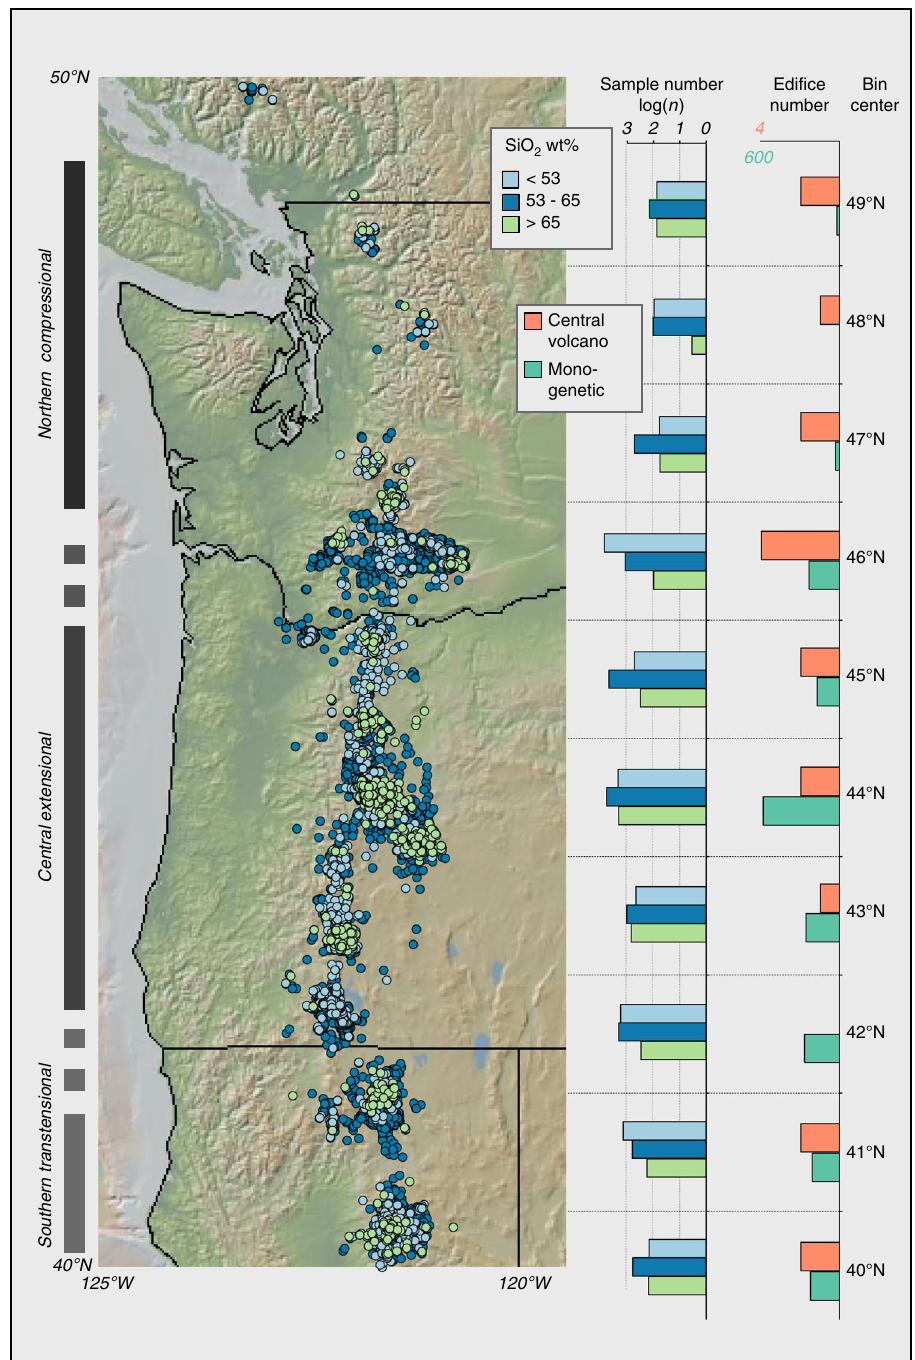
Fig. 1 Map of Cascades Arc showing locations of geochemical samples and selected summaries of the existing datasets. The map and the accompanying histograms illustrate the available Quaternary Cascade volcanic rock compositions from Earthref.org separated into three categories according to SiO 2 content (colors are the same for map symbols), the number of major edi fi ces, and monogenetic vents from Hildreth